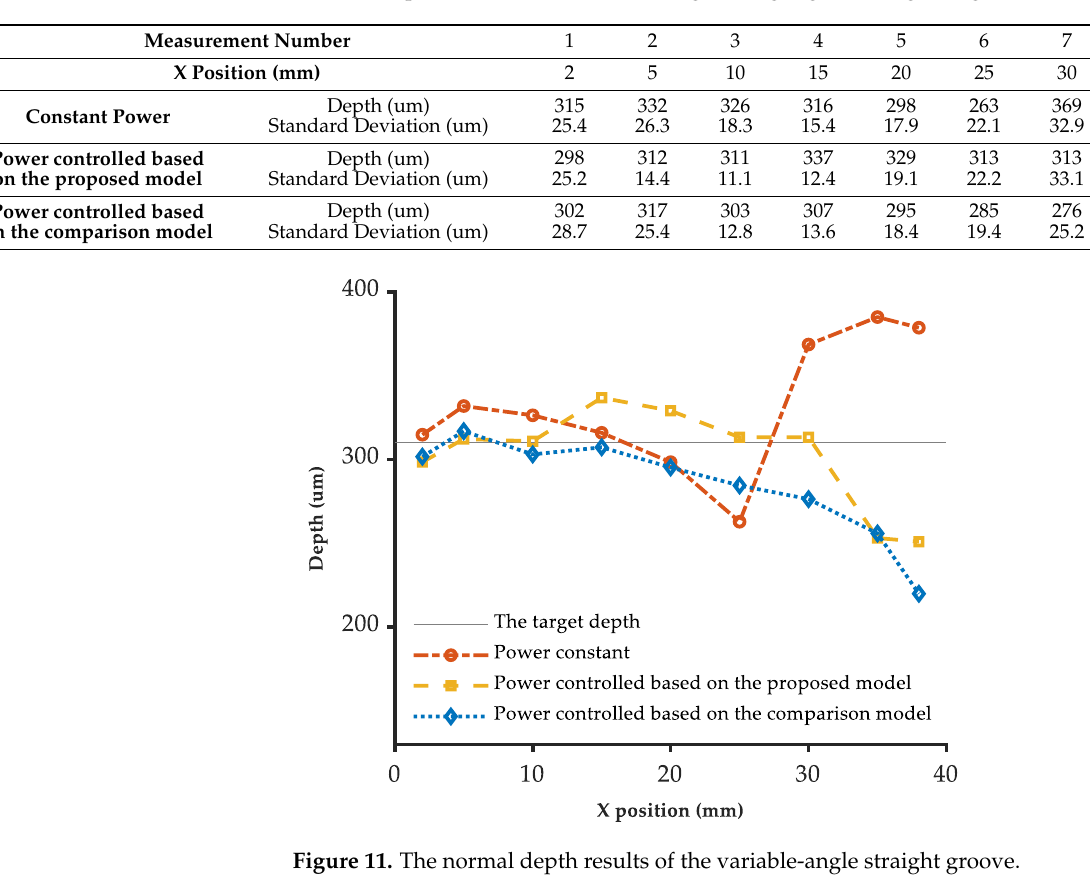
Table 8. Depth results of the variable-angle straight groove engraving.